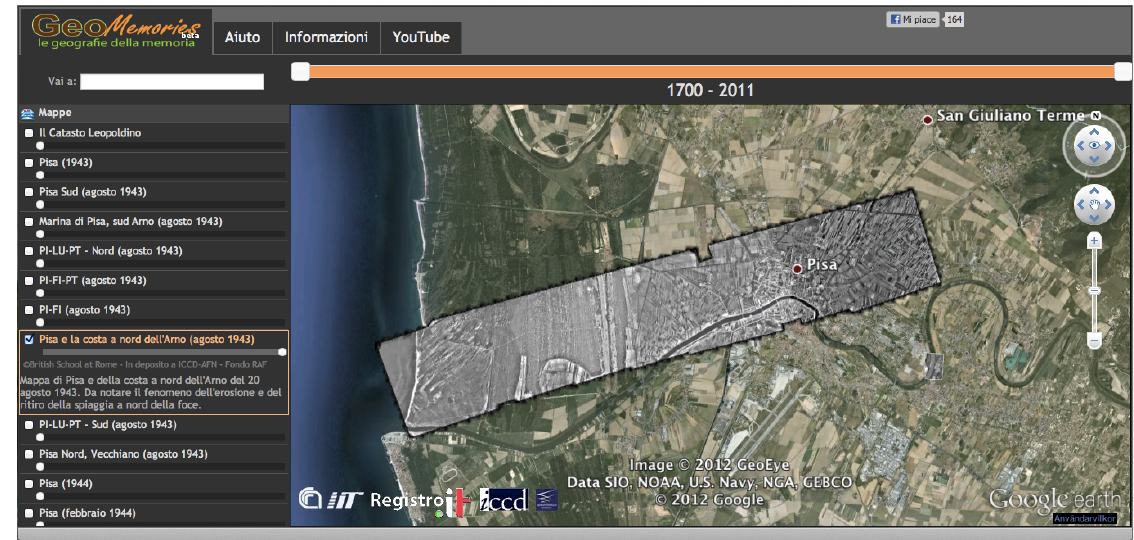
The GeoMemories application. Note the Google Earth navigation tools on the right, the slider to select a time frame on top, and the historical map selector on the left. One historical map is chosen, which is composed of several photos taken by RAF during a flight in August 1943 over the city of Pisa in Italy. ( c (cid:13) MiBAC-ICCD, Aerofototeca Nazionale, fondo RAF. c (cid:13) 2010